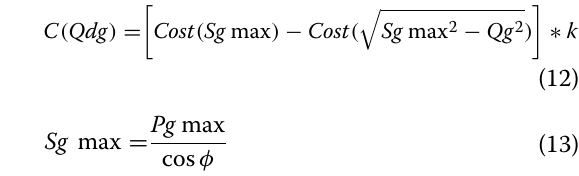
Table 4 Results for 15-bus system